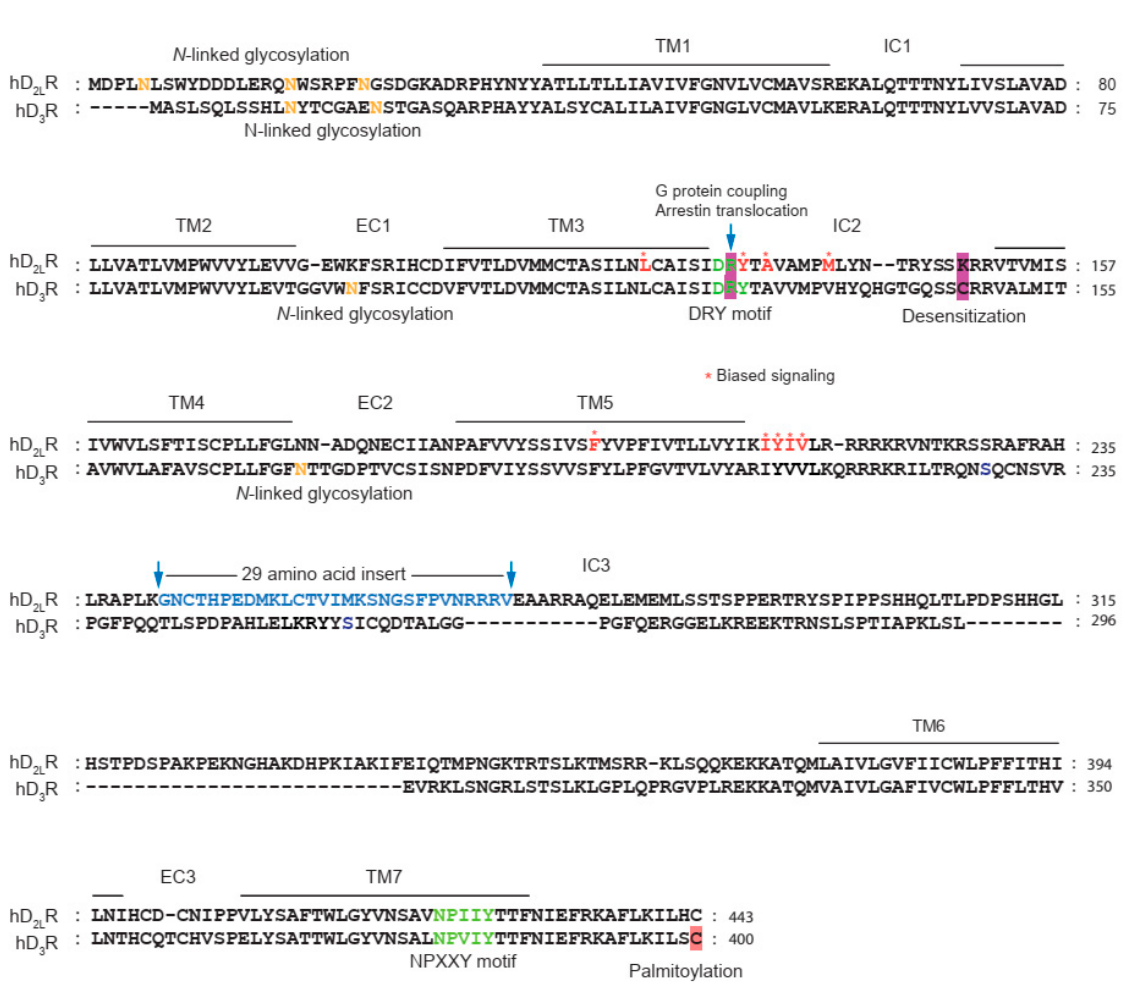
Figure 3. Sequence alignment of dopamine D 2 and D 3 receptors. D 2L R represents alternatively spliced long form of dopamine D 2 receptor. The asparagine residues (N) indicated by orange letters located within the N-terminal tail or within the extracellular loops represent potential N -linked glycosylation sites. Asterisks indicate amino acid residues involved in biased signaling. For details, please refer to the text.